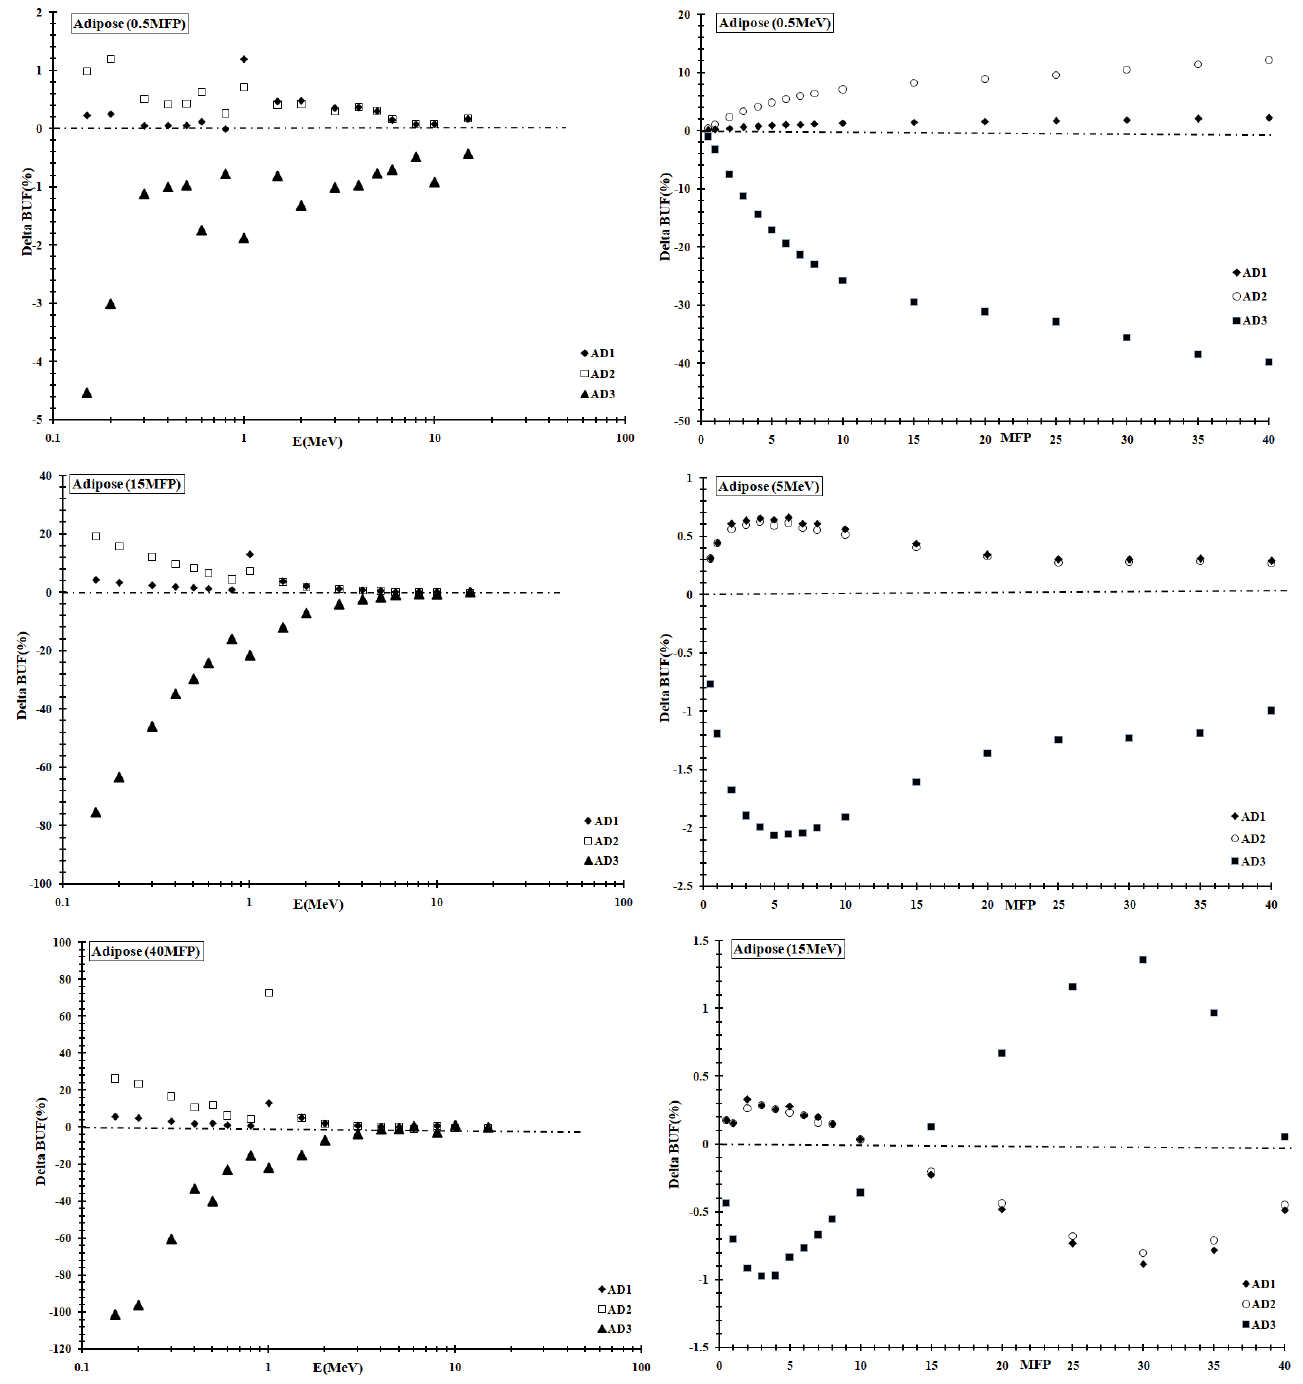
Figure 5. Relative percentage deviation of BUF values of substitute materials for adipose tissue as a function of: ( left side ) photon energy for fixed depths of 0.5, 15 and 40 mfp and ( right side ) depth for fixed photon energies of 0.5, 5 and 15